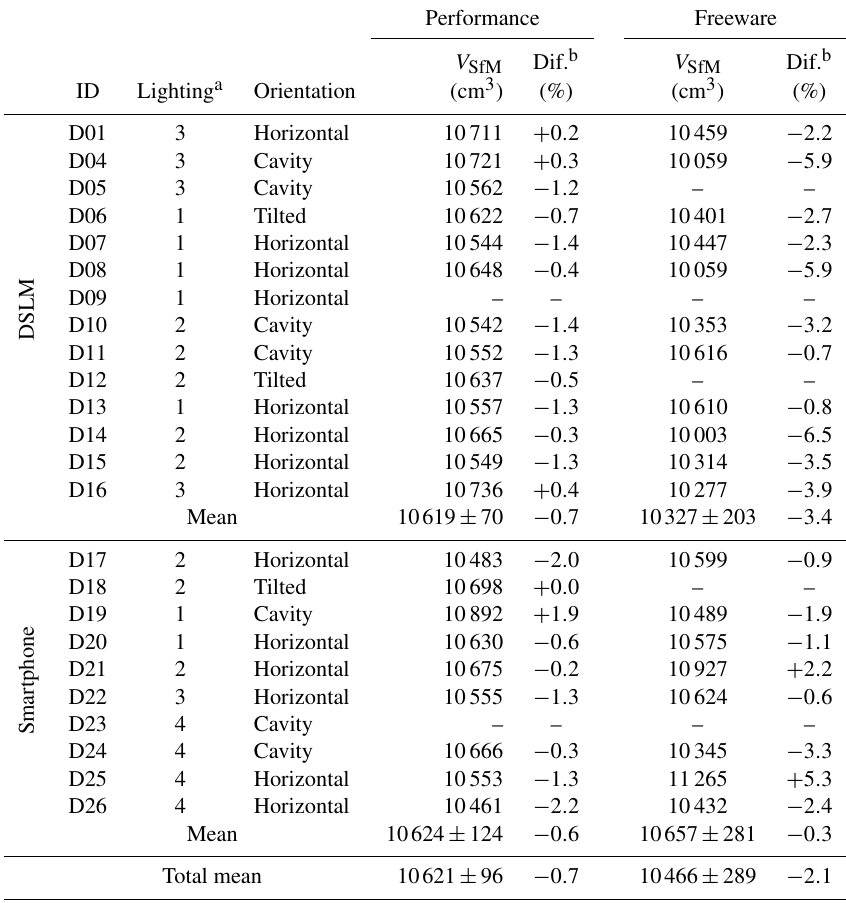
Table 2. Scenario details and derived volumes ( V SfM ) of the artificial pit by applying the performance and freeware